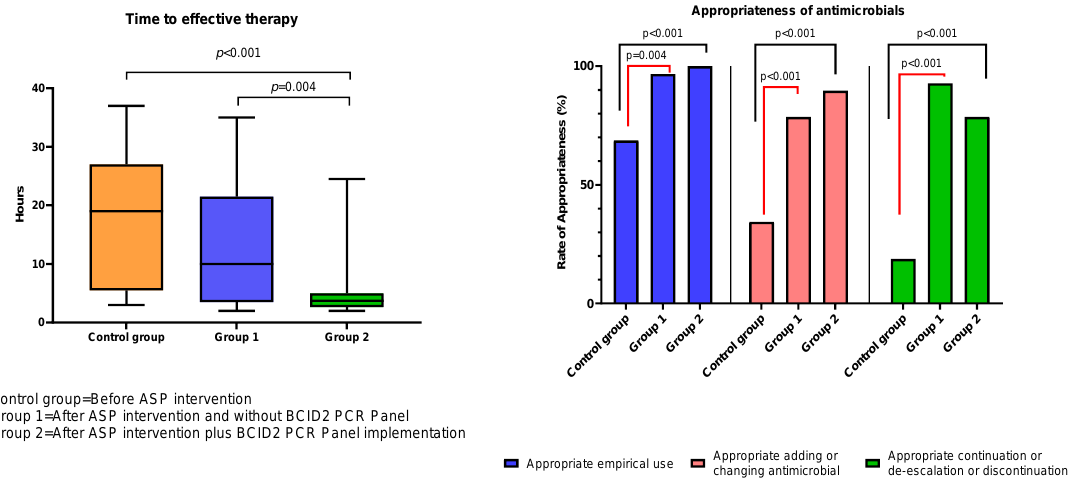
Figure 2. Time to effective therapy and appropriateness of antimicrobials. Comparison between intervention periods and control group. Abbreviations: ASP = antimicrobial stewardship program, BCID2 = Blood Culture Identification 2 (BCID2) Panel.